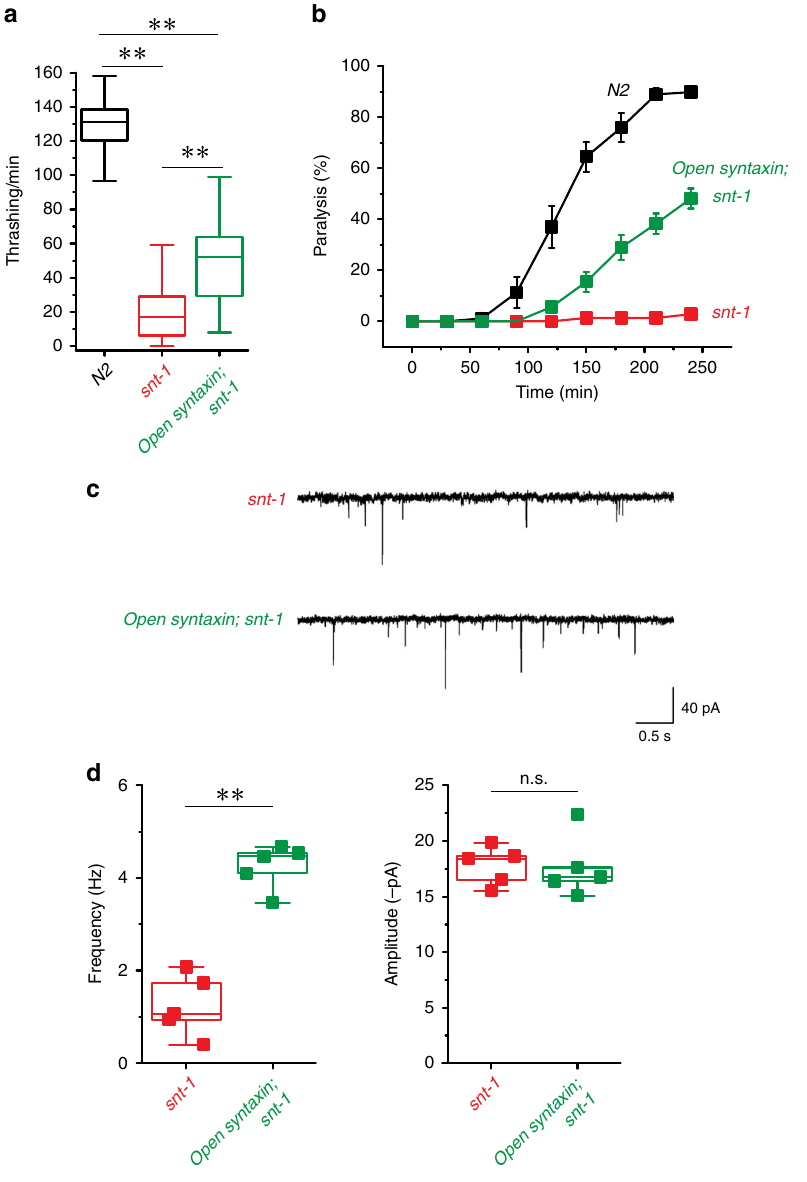
Fig. 2 Open syntaxin rescues acetylcholine secretion defects in snt-1-null C. elegans . a Box-and-whisker plots of thrashing assay for N2, snt-1 , and open syntaxin; snt-1 double mutants in M9 buffer. snt-1 worms displayed impaired thrashing rates (20.1 thrashes/min), which was increased by the introduction of open syntaxin in the double mutant (48.9 thrashes/min). n = 40 for each strain. In one-way ANOVA statistical tests, F (2,117) = 388 and p = 0.00. Tukey ’ s test was performed for means analysis in ANOVA. N2 vs. snt-1 : ** p = 0.00, snt-1 vs. open syntaxin; snt-1 : p = 0.00, N2 vs. open syntaxin, snt-1 : ** p = 0.00. b Aldicarb assays of N2, snt-1 , and open syntaxin; snt-1 double mutants. open syntaxin; snt-1 animals displayed slightly increased sensitivity to aldicarb compared to snt-1 single mutants, which were resistant to aldicarb ’ s paralyzing effects. n = 6. Each assay was conducted with 15 – 20 worms. Error bars represent SEM. c Representative mPSC traces recorded from snt-1 and open syntaxin; snt-1 worms. d Box-and-whisker plots overlaid with the corresponding data points (squares) of mPSC frequency (left) and amplitude (right) of snt-1 and open syntaxin; snt-1 worms. Two-sample two-sided t-test was performed. ** p = 0.00; n.s. p = 0.93. n = 5 for snt-1(md290) and open syntaxin; snt-1(md290) animals. Box-and-whisker plots represent the median (central